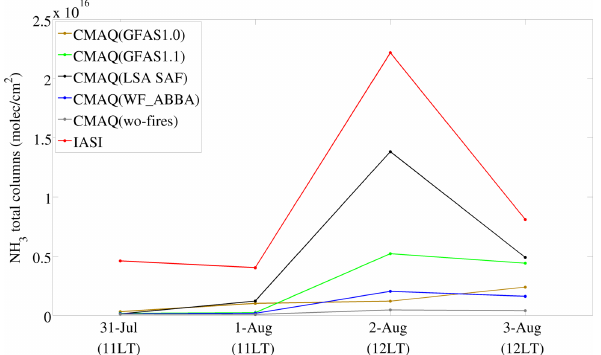
Figure 13. Temporal variations of modeled and observed NH 3 total column from 31 July to 3 August 2008 averaged over the area of study. The averaged values are a mean of all measurements within the studied area, weighted by the relative retrieval error of ammonia measurements following Eq.